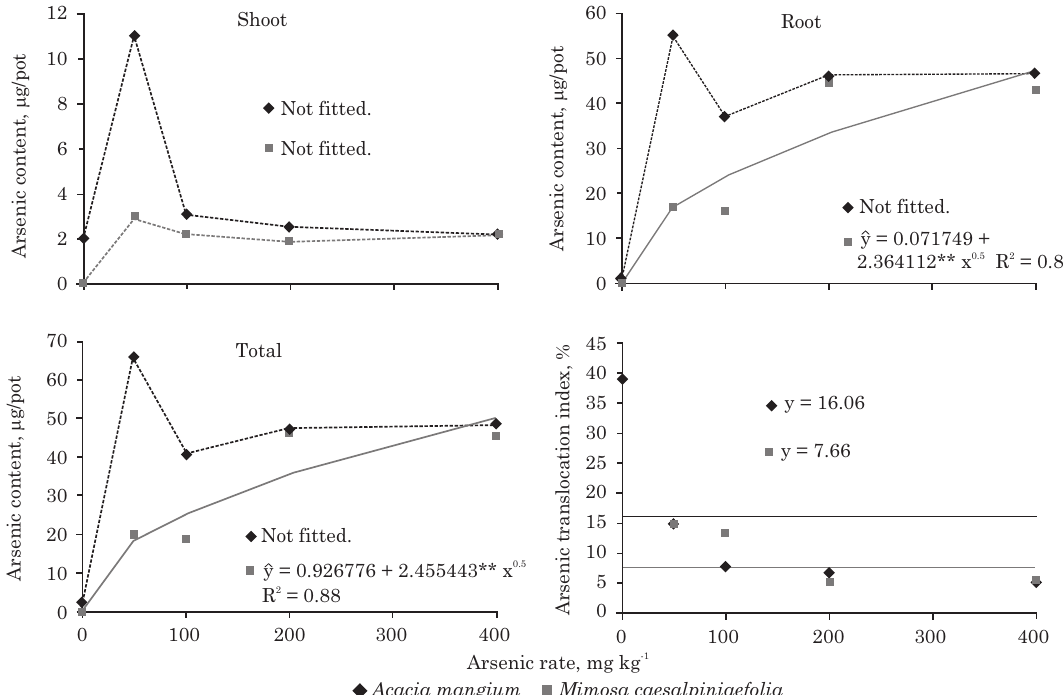
Figure 4. Arsenic content in the shoot (SAsC), root (RAsC), whole plant (TAsC) and As translocation index (AsTI) of Acacia mangium ( uuuuu ) and Mimosa caesalpiniaefolia ( nnnnn ) seedlings as a function of the As rate added to the substrate. ** Significant at 1 %